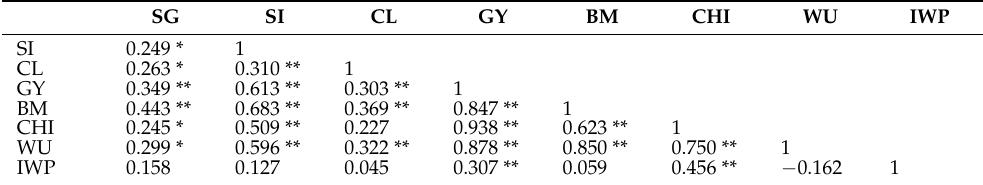
Table 7. Correlation analysis between various parameters of maize crop under different irrigation methods, water stress and mulching